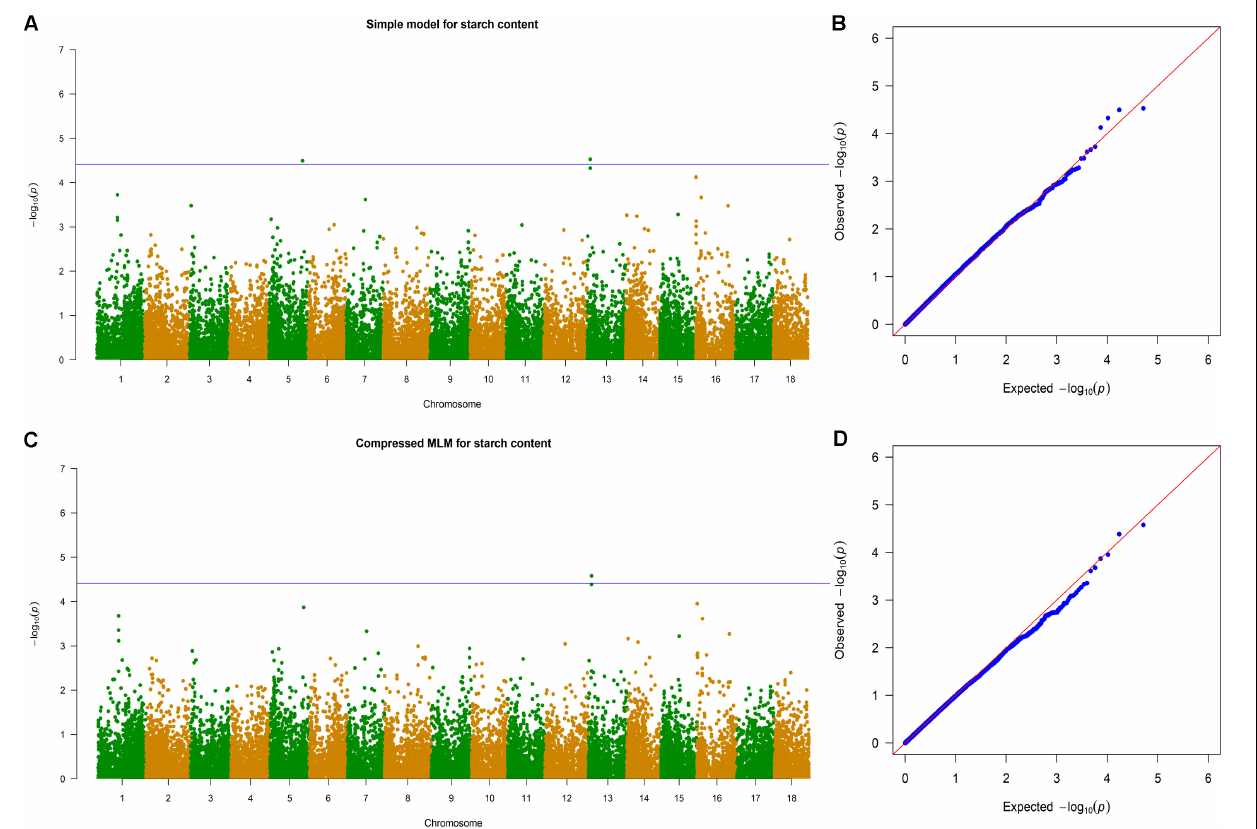
FIGURE 5 | Genome-wide association analysis of starch content. (A) Manhattan plots of simple model for starch content. Negative log 10 -transformed P values from a genome-wide scan are plotted against position on each of the 18 chromosomes. Genome-wide significance threshold is depicted as a blue horizontal dashed line. (B) Quantile–quantile plot of the simple model for starch content. (C) Manhattan plots of compressed MLM for traits as in (A) . (D) Quantile–quantile plot of the compressed MLM for starch content.